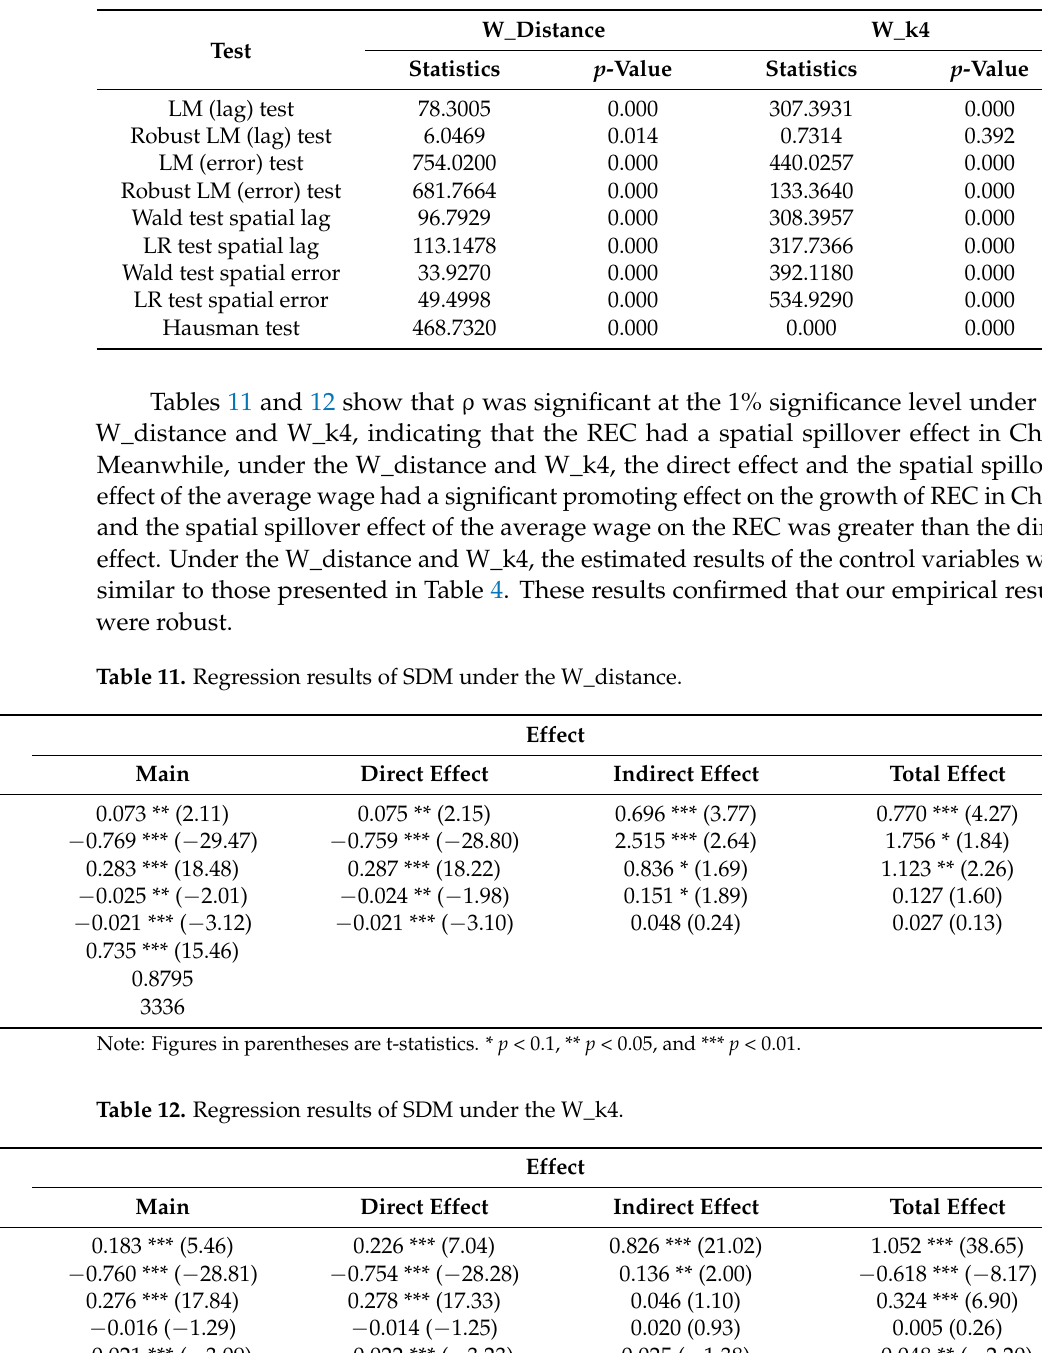
Table 10. Spatial models test results under the W_distance and W_k4.